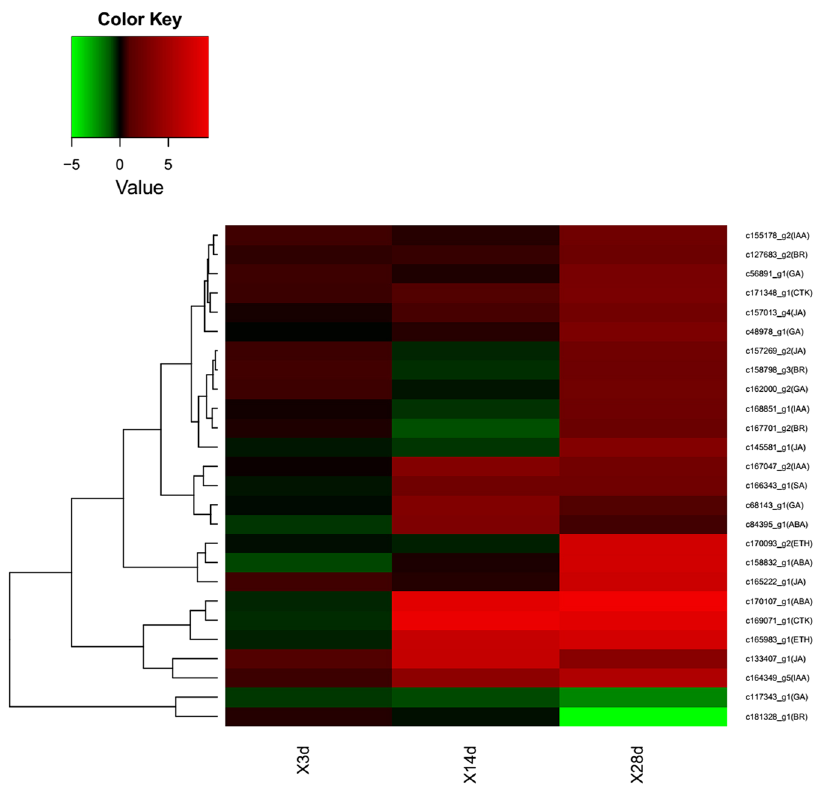
Figure 5. The expression levels of 26 hormone biosynthesis in 3d, 14d and 28d treatment. The RPKM values of hormone biosynthesis genes after infected by Mi were used for hierarchical cluster analysis with the R heatmap package. Details of annotated unigenes shown on the right are provided in Supplementary Fig.